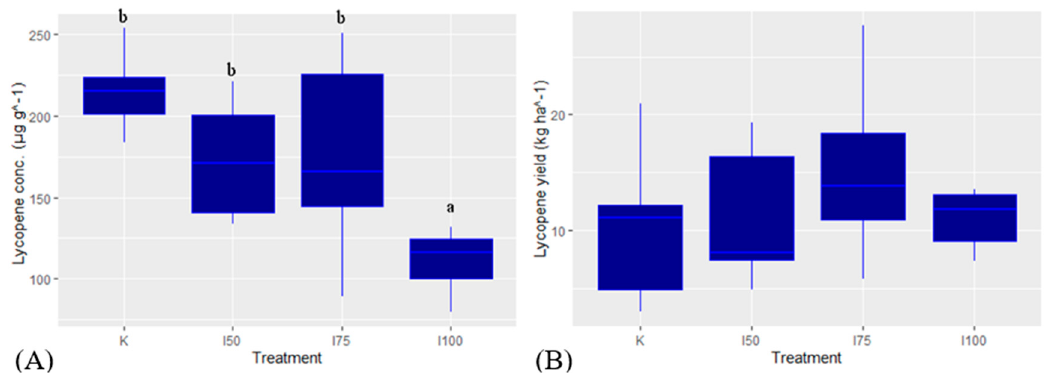
Figure 6. Effect of different water supplies on lycopene concentration ( A ) and yield ( B ) in tomato fruits. The values represent the average of two years. The values having the same letter above the boxes are statistically not significant ( p > 0.05). No significant difference was found in the case of lycopene yield ( B ).